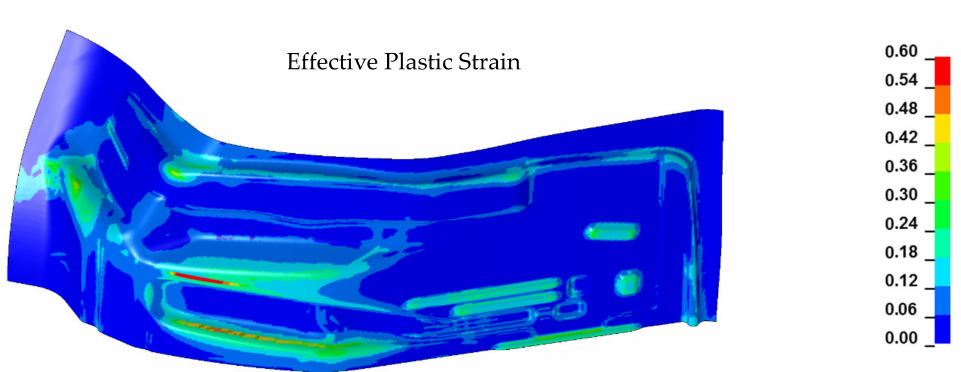
Figure 10. Results of numerical simulation based upon the assumption of uniformly distributed pressure. Maximum strain is 1.21.